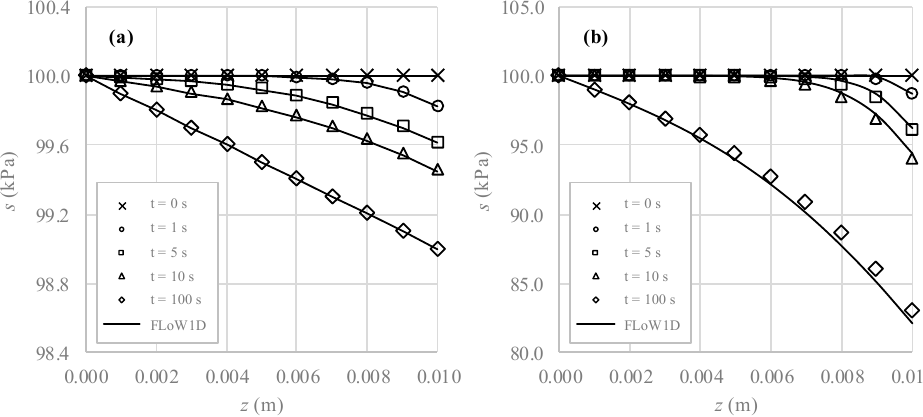
Figure 3. Suction isochrones ( s ) obtained with FLoW1D vs. reference solution. ( a ) Analytic and ( b ) SEEP/W-Geoslope®. Markers, reference solution; solid lines, FLoW1D results.